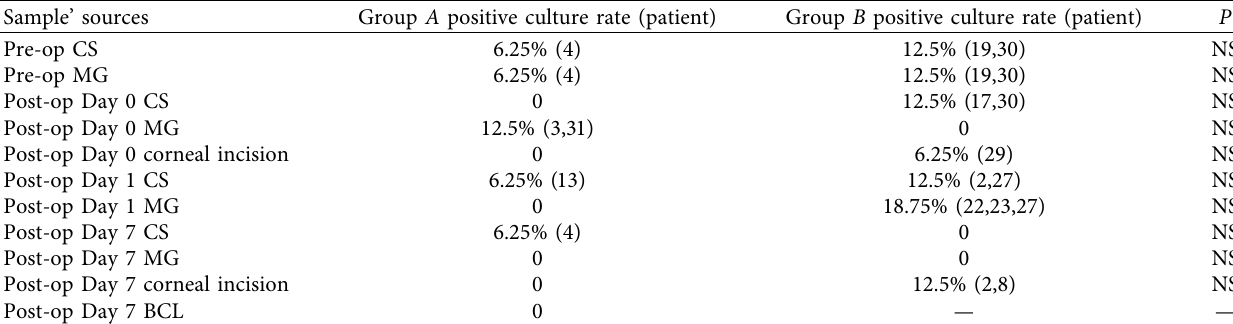
Table 4: The incidence of positive bacterial cultures and species